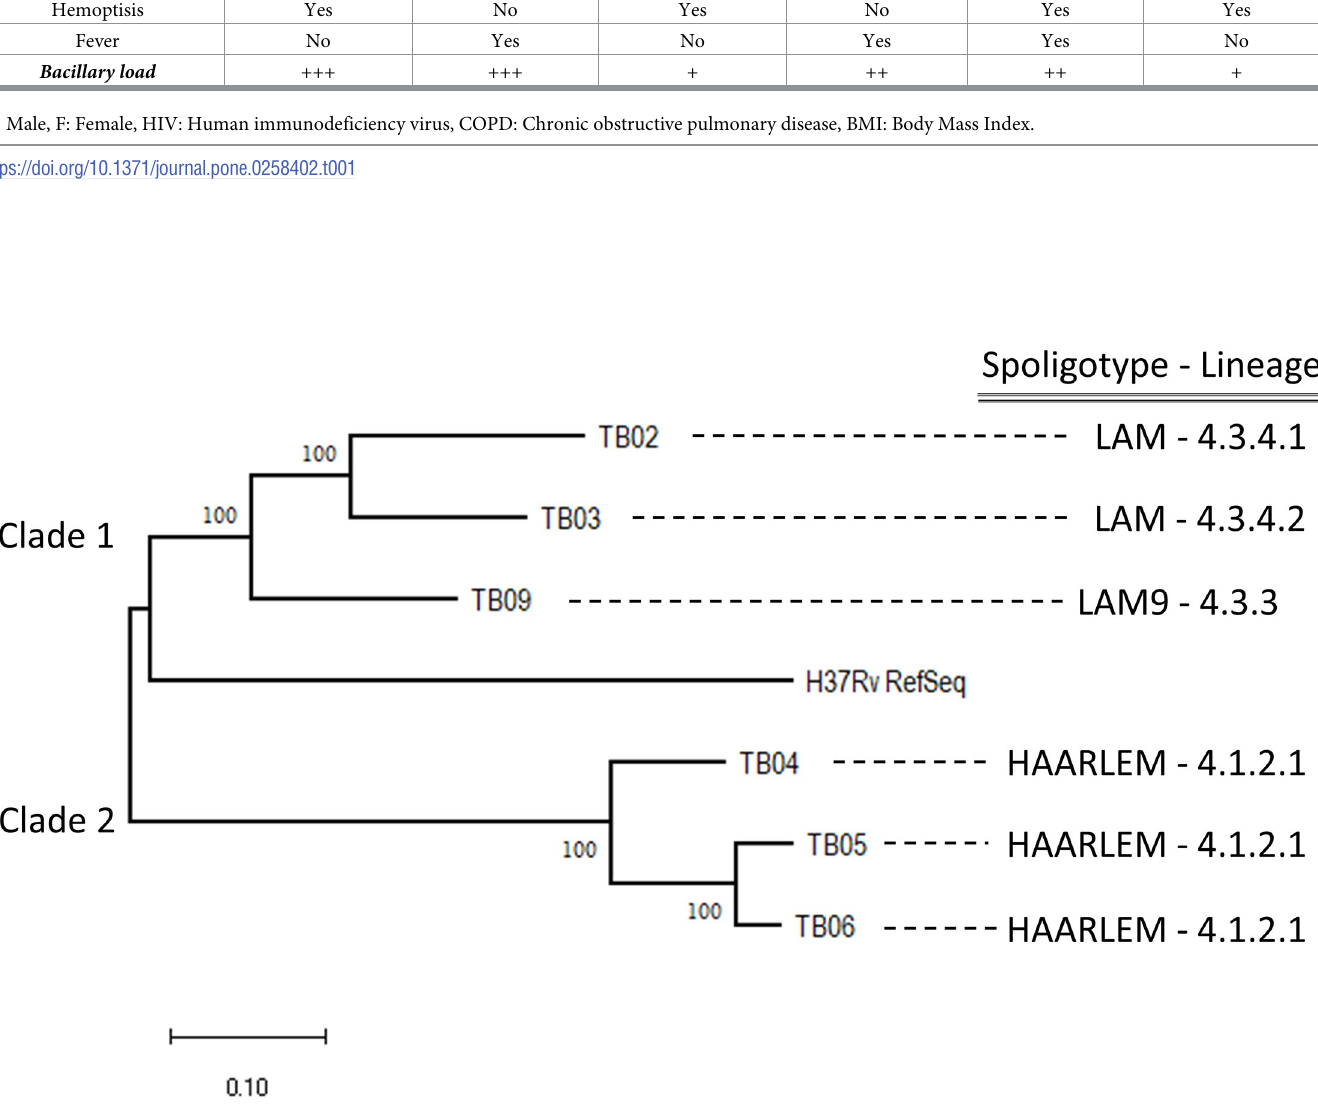
Fig 2. Clustering by phylogenetic analysis and lineage assignment of six M. tuberculosis isolates form Chinchina´ (Caldas, Colombia).